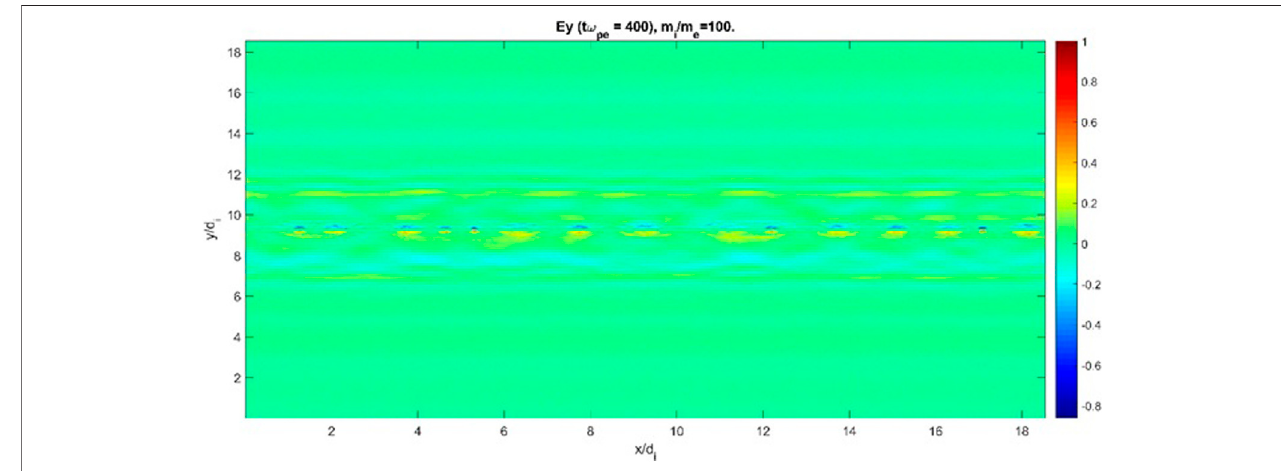
FIGURE 10 | E y plot at time t ω pe (cid:1) 400 for m i / m e (cid:1)